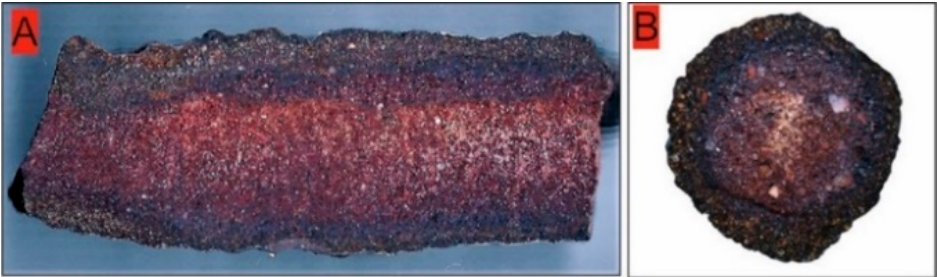
Figure 1. Cut side view ( A ) and upright view ( B ) of the studied